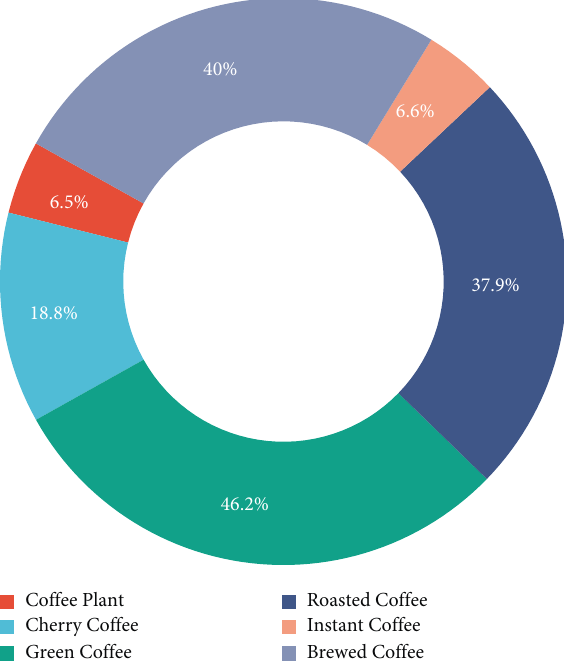
Figure 7: Percentage of the articles classified by type of samples used for quality